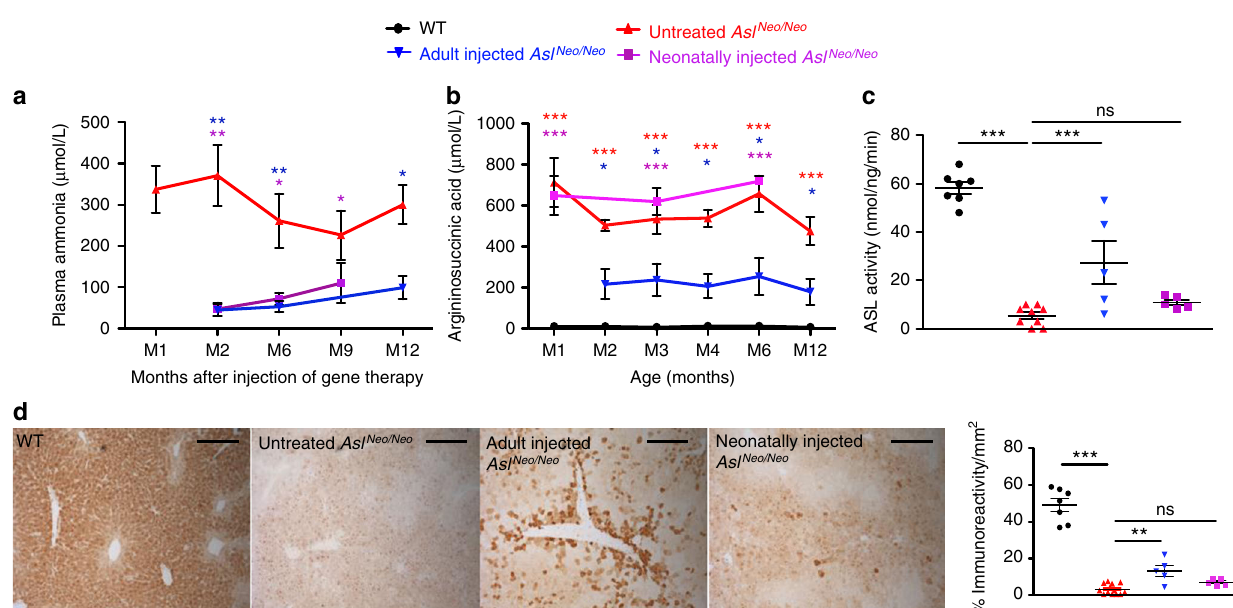
Fig. 4 AAV8.EFS. mAsl controls hyperammonaemia and restores a functional urea cycle. Concentration of ( a ) plasma ammonia and b argininosuccinic acid in dried blood spots overtime in WT, untreated, adult-injected and neonatally injected Asl Neo/Neo mice. c Liver argininosuccinate lyase (ASL) activity at culling. d Representative images of ASL-stained sections of liver in WT, untreated, adult-injected and neonatally injected Asl Neo/Neo mice ( n = 5) and computational quanti fi cation of ASL immunostaining. Horizontal lines display the mean ± SEM. One-way ANOVA with Dunnett ’ s post-test compared to a , b WT and c , d untreated Asl Neo/Neo . ns — not signi fi cant; * p < 0.05; ** p < 0.01; *** p < 0.001. d Scale bars 500 μ m. WT n = 13 – 20 (littermates aged 9 or 13 months); untreated Asl Neo/Neo n = 10 – 12 (littermates aged 1 – 13 months as less than 10% of the animals had survived at the end of the study); adult- injected Asl Neo/Neo n = 4 – 5 (aged 13 months); neonatally injected Asl Neo/Neo n = 3 – 5 (aged 9